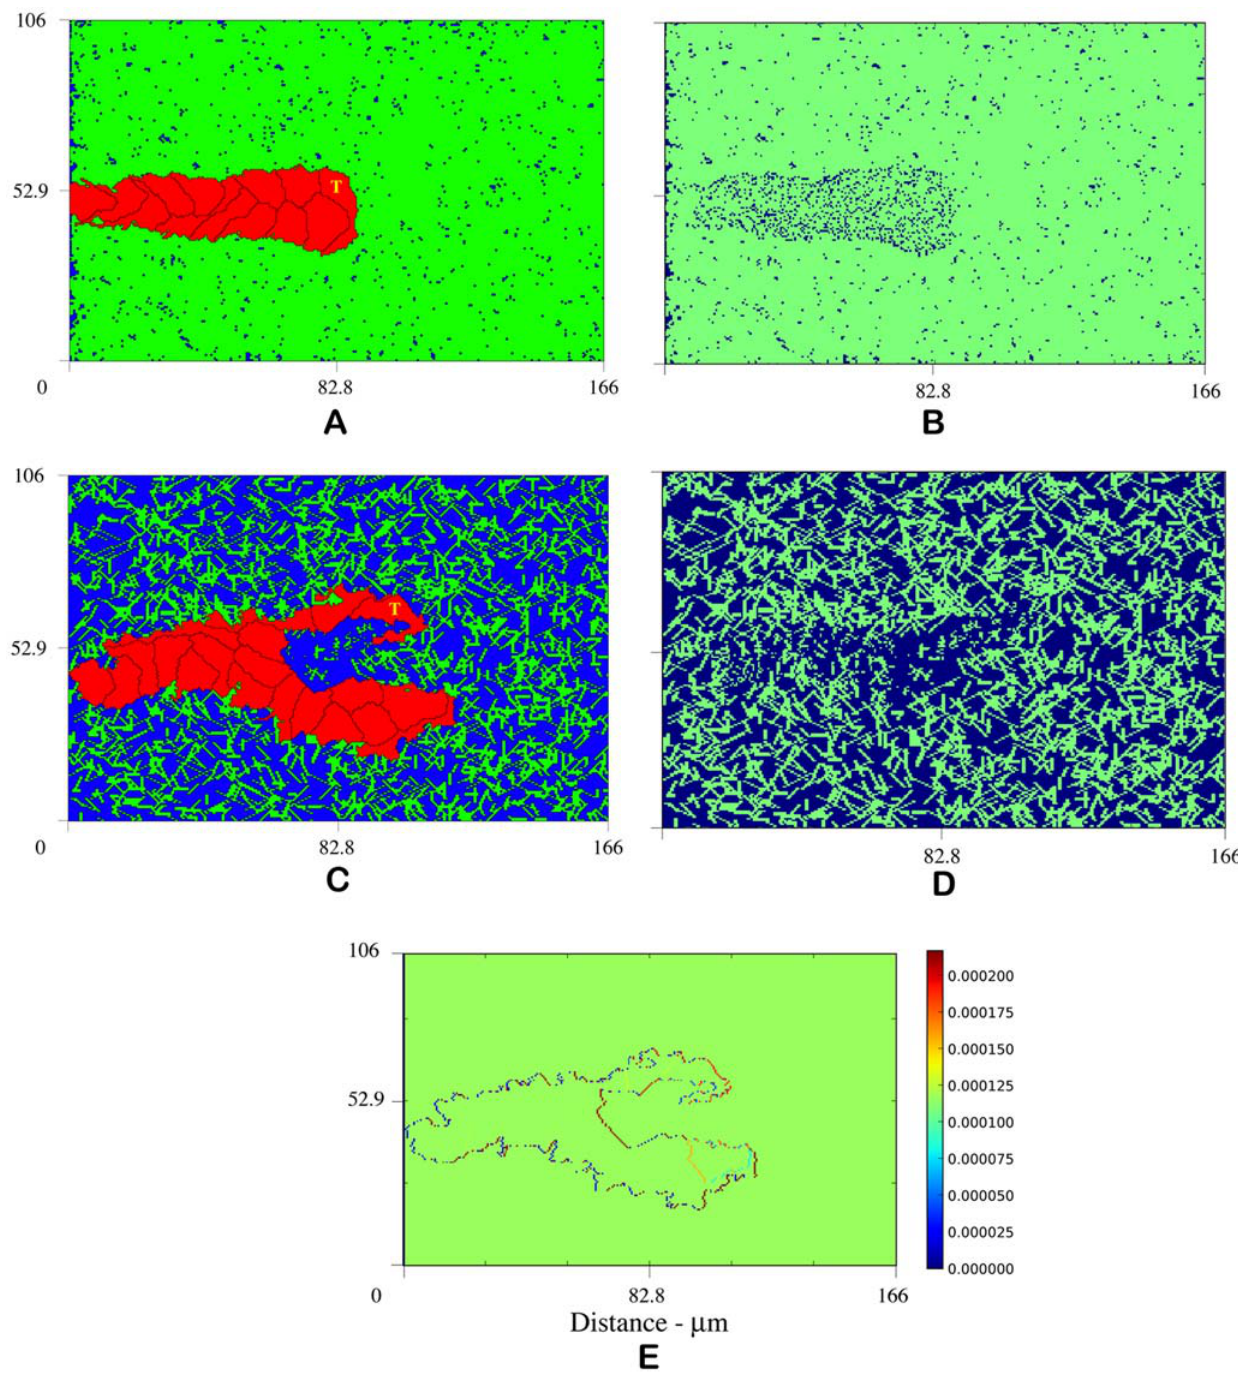
Figure 7. Without degradation, angiogenesis is inhibited at r ~ 0 : 975 (Figure 3F). (A) shows that tip cell matrix degradation promotes sprout development at r ~ 0 : 975 by carving out a path for migration, called a vascular guidance tunnel (B). (C) depicts sprout formation and branching with ECM degradation at r ~ 0 : 4 , a density not typically conducive to branching, suggesting that high matrix heterogeneity (D) created by tip cell degradation may be a mechanism for branching (Video S3). (E) VEGF gradient profile (pg) shows strong gradient along leading edges of sprout. Snapshots at 14 hours. of the sprout. This is because of the chemotactic sensitivity Figure 8 shows how the average extension speed of a sprout differential between the tip cell and the stalk cells. Here the relative varies with increasing chemotactic sensitivity, x . Average speeds ) is greater than pressure on a cell to maintain its target volume ( c are calculated at 14 hours. Above x ~ 1 : 6 : 10 6 , the physical e the chemotactic energy of the stalk cells, but not greater than the integrity of the endothelial cells is compromised and cells dissociate chemotactic incentives for the tip cell. Thus the tip cell detaches. due to the relatively strong chemotactic stimulus. Below x ~ 1 : 10 4 ,